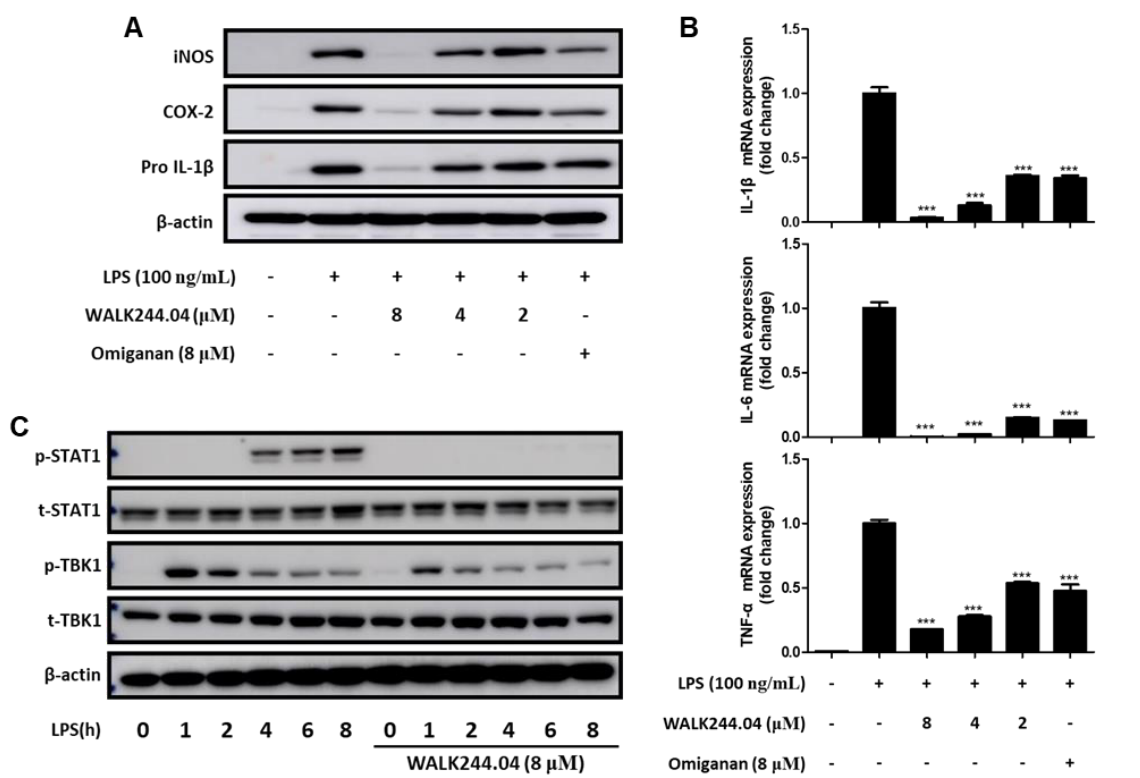
Figure 5. Anti-inflammatory effects of WALK244.04 peptide in Raw264.7 cells. The cells were pretreated with the peptide at indicated concentrations for 5 min, followed by stimulation with LPS (100 ng/mL) to induce inflammatory responses. ( A ) iNOS, COX-2, and pro-IL-1 β expression levels were estimated by Western blot analysis after 16 h of LPS treatment. ( B ) The mRNA expression of IL- 1 β , IL-6, and TNF- α was determined by quantitative real-time PCR upon 3 h of stimulation with LPS. All bar graphs represent the mean ± SEM of three independent experiments (*** p < 0.001, significantly different from the control group treated with LPS alone). ( C ) The phosphorylation of STAT1 and TBK1 was examined by Western blot analysis at different time points after the LPS treat- ment.